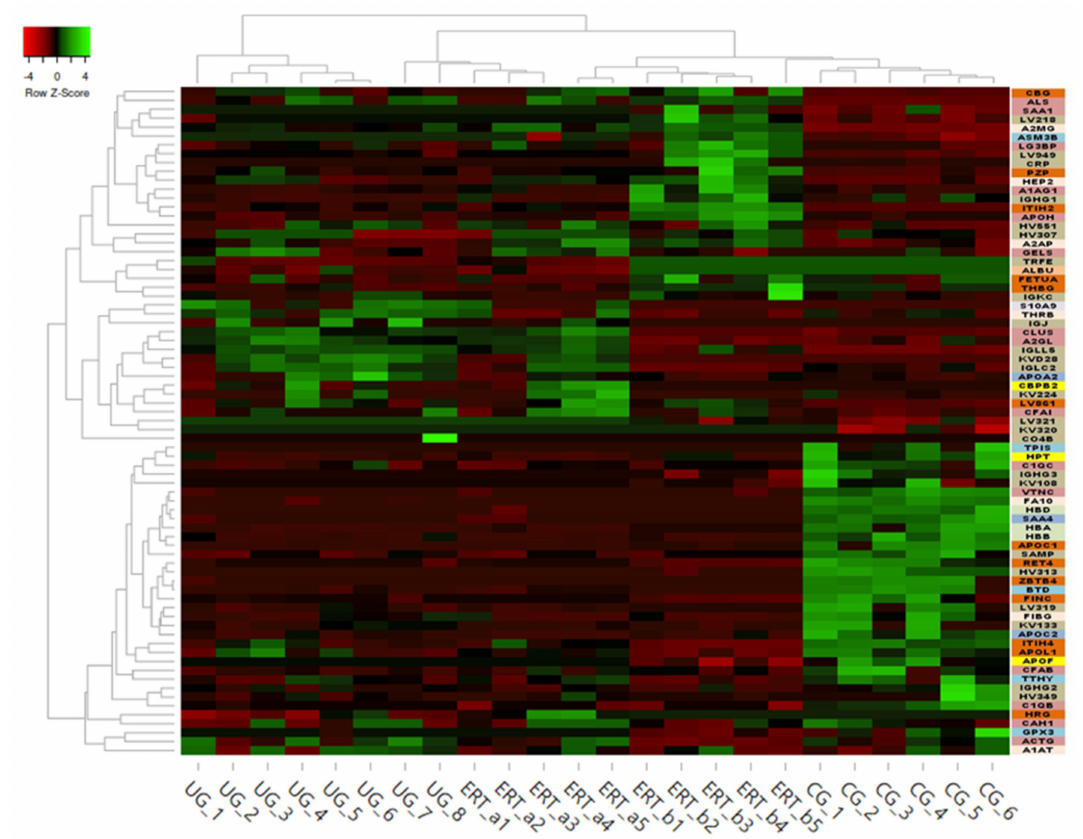
Figure 8. Heatmap depicting the expression profiles of different proteins (also shown in Tables 2–4) as determined by SWATH quantitative analysis. The relative abundance of each protein is reflected by the colors in the heatmap, based on the z-score of the protein’s normalized peak area. The dendrogram represents the biological replicates of the UG, ERT-a, ERT-b, and CG groups. Proteins, listed in the sidebar on the right, are color coded according to their function, as follows: apolipoprotein-related proteins, dark green; blood coagulation, purple; calcium binding, dark orange; carrier proteins, light green; cytoskeletal proteins, light pink; immune system, grey; metabolic processes, yellow; metabolic interconversion, light blue; other functions, white; protein binding, pink; transport, light